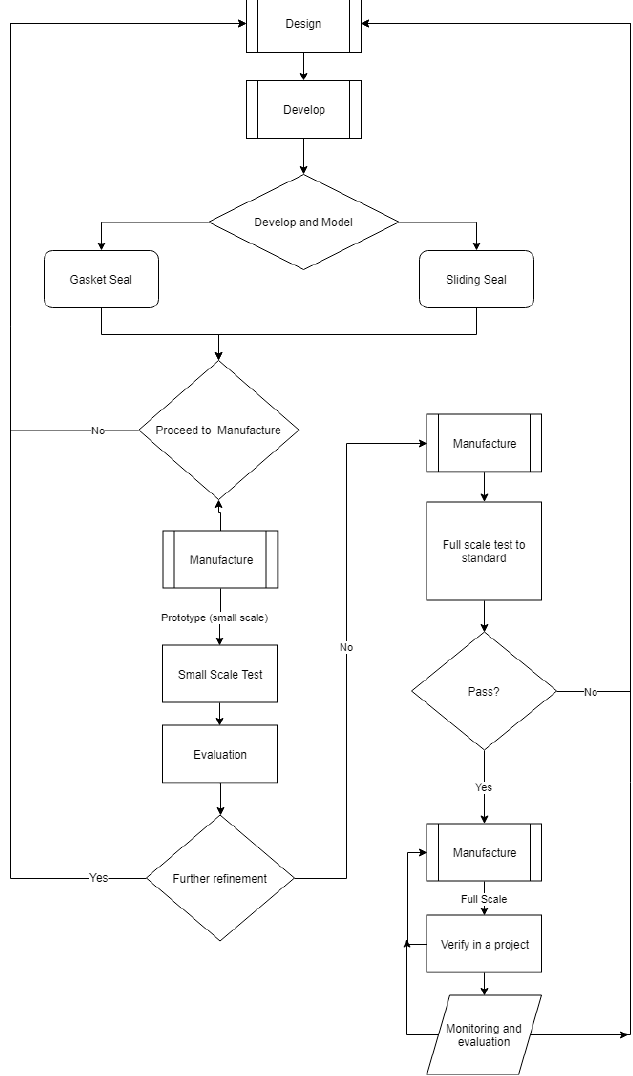
Figure 9. High level overview flowchart of the method